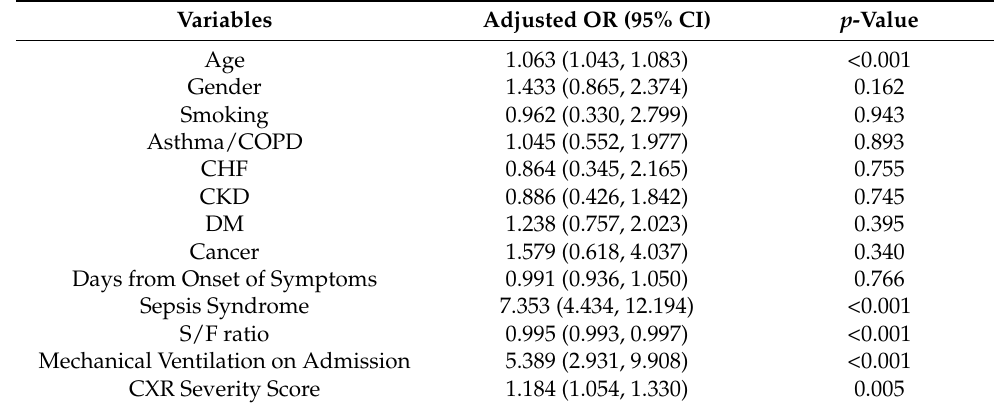
Table 3. Binary logistic regression analysis of the independent factors predicting mortality in COVID- 19